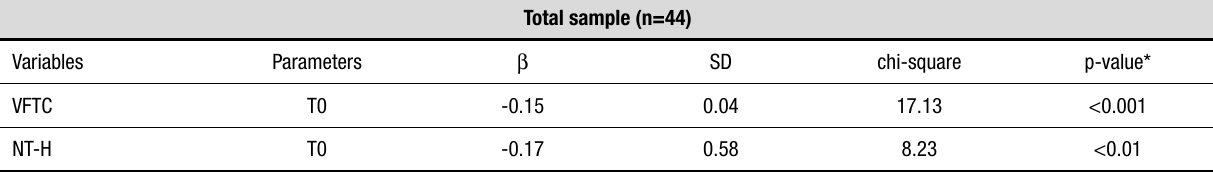
Table 4. Effect size results ( β ) of the cognitive and scale evaluations under the effect of group, time and the interaction group*time in estimates of specific